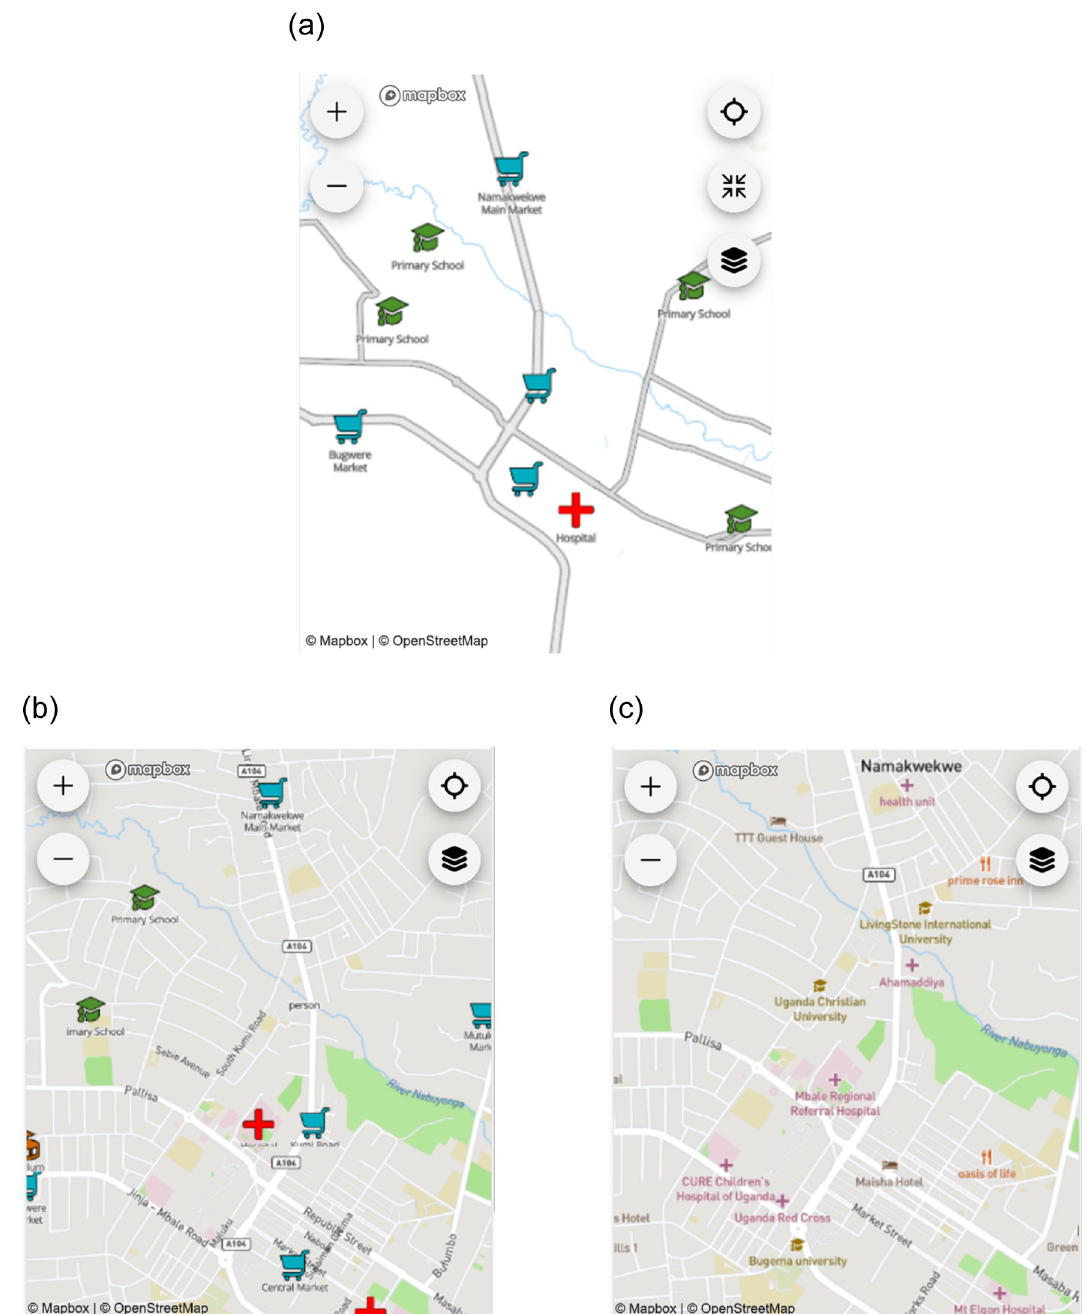
Fig 2. Types of base maps with a) Landmark map, b) Simple map, and c) Mapbox Streets base map (note that the figures use map data from Mapbox and OpenStreetMap and their data sources; also see mapbox.com/about/maps and openstreetmap.org/